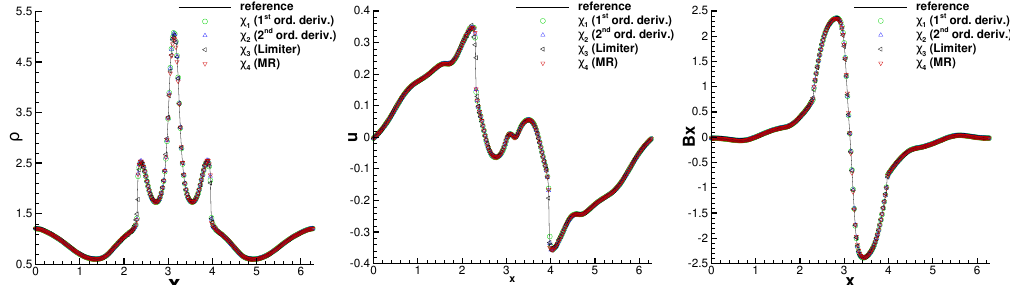
Figure 5. Results for the GRMHD Orszag-Tang vortex problem in flat space–time (SRMHD) at t = 2 obtained with ADER-DG- P 5 schemes supplemented with a posteriori subcell finite volume limiter and using different refinement estimator functions χ . A set of 1D cuts taken at y = 10 − 2 are shown. From ( left ) to ( right ): the rest-mass density, the velocity u and the magnetic field component B x . One can note an excellent agreement between the reference solution and the ones obtained on different AMR grids.